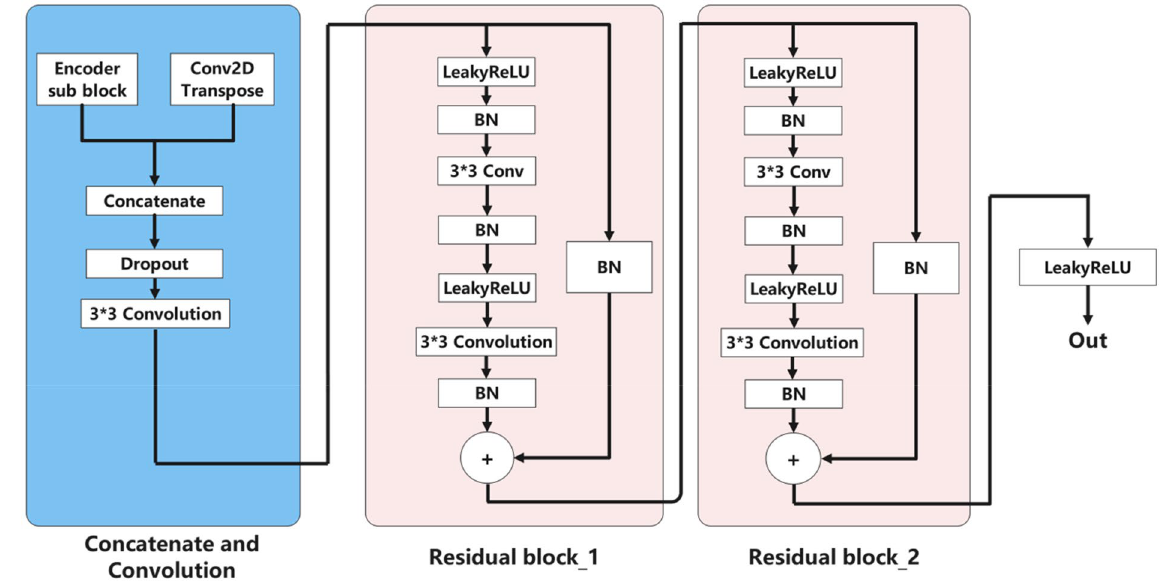
Figure 3. Encoder sub-block as shown.BN refers to Batch Normalization.